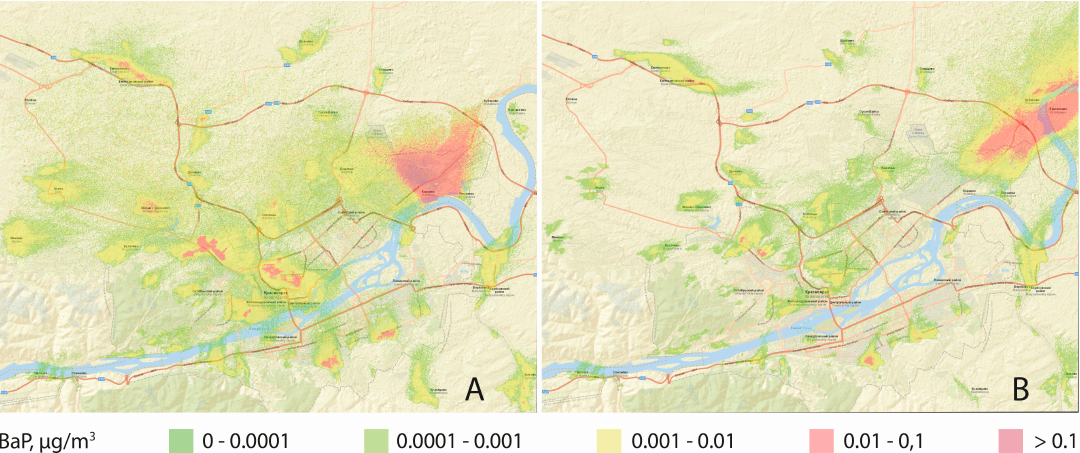
Figure 12. Spatial distribution of benzo(a)pyrene (BaP) in the surface layer of the Krasnoyarsk atmosphere (2 m above the ground) at the beginning ( A ) and the end ( B ) of adverse weather conditions (AWC).